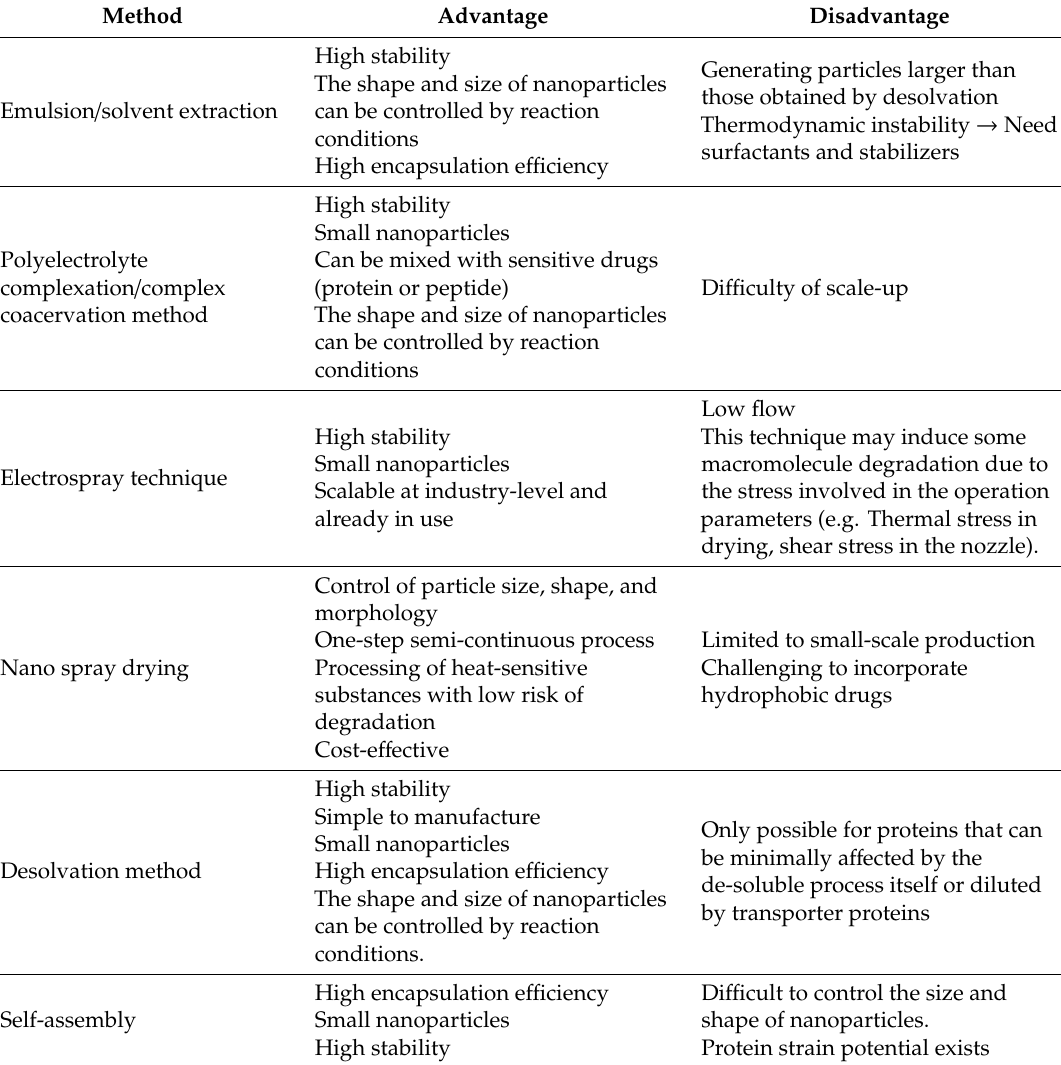
Table 2. Advantages and disadvantages of each protein nanoparticle generation